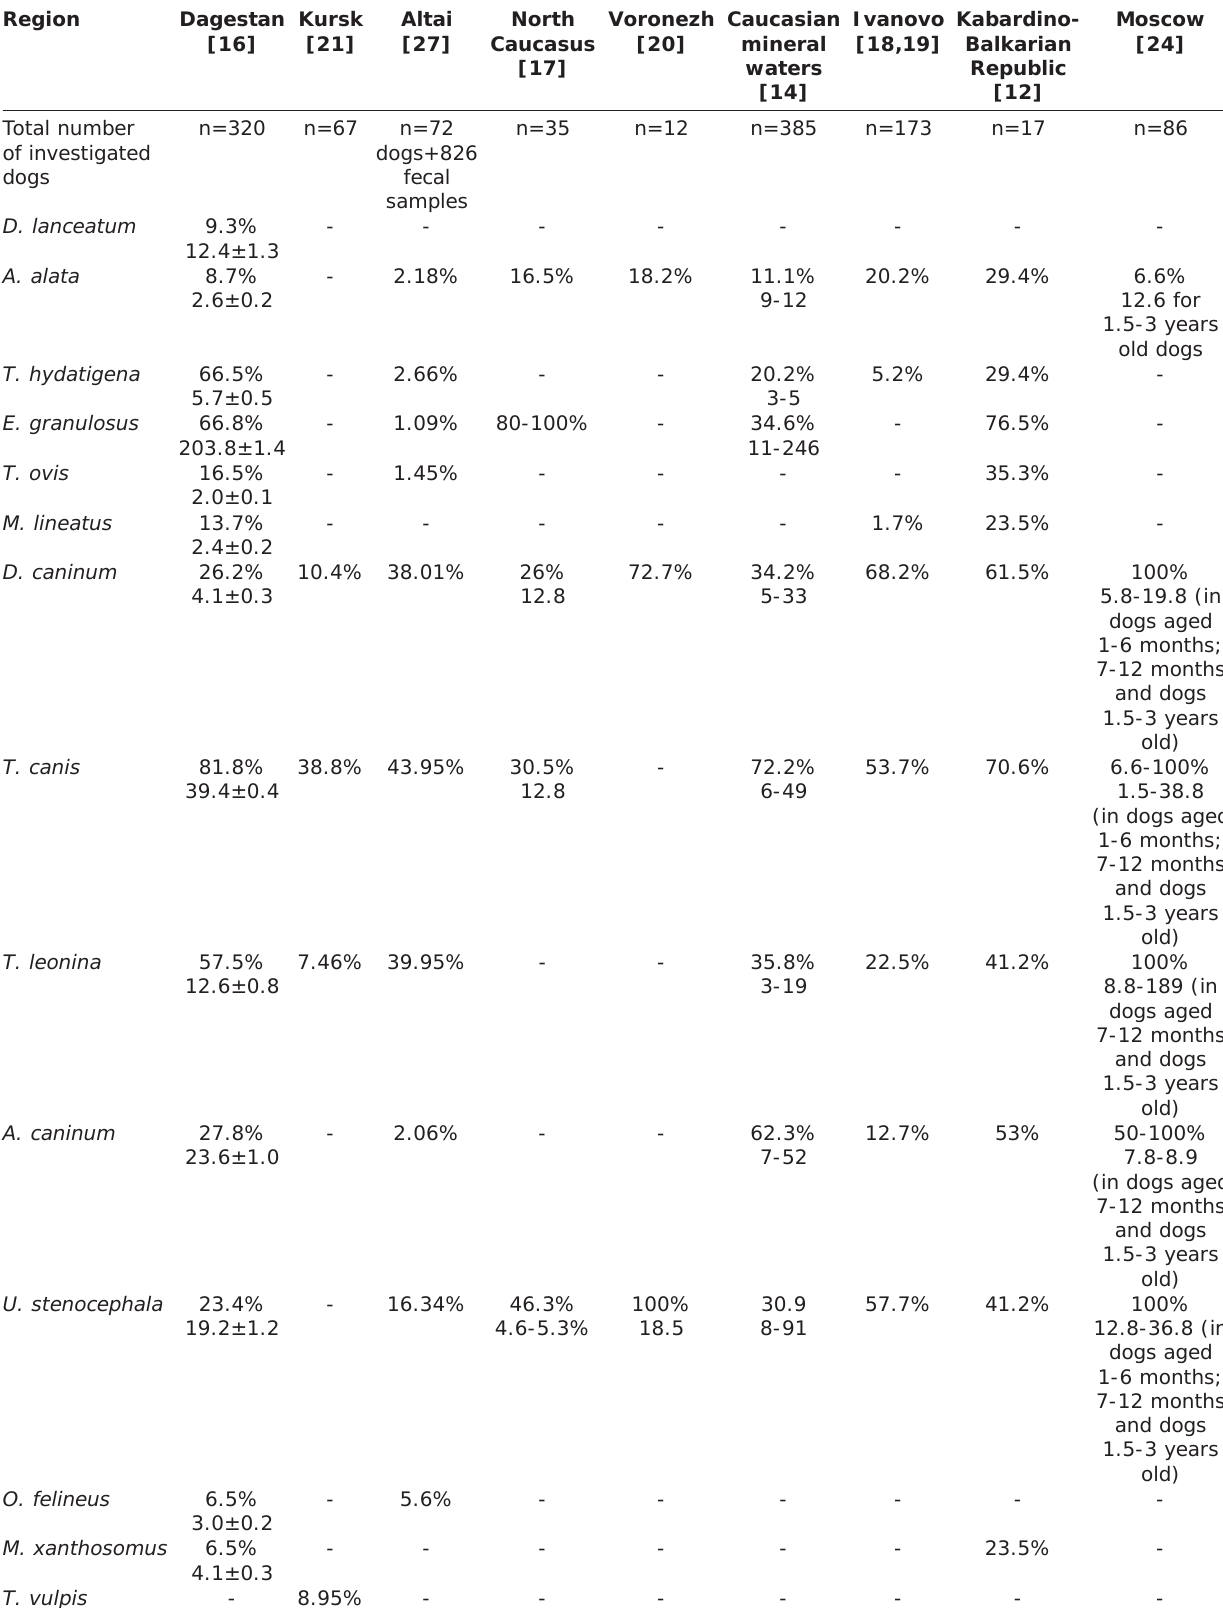
Table-2: Prevalence and intensity (min and max intensity rates or mean intensity) data of dogs’ gastrointestinal helminths based on autopsy examination. Region